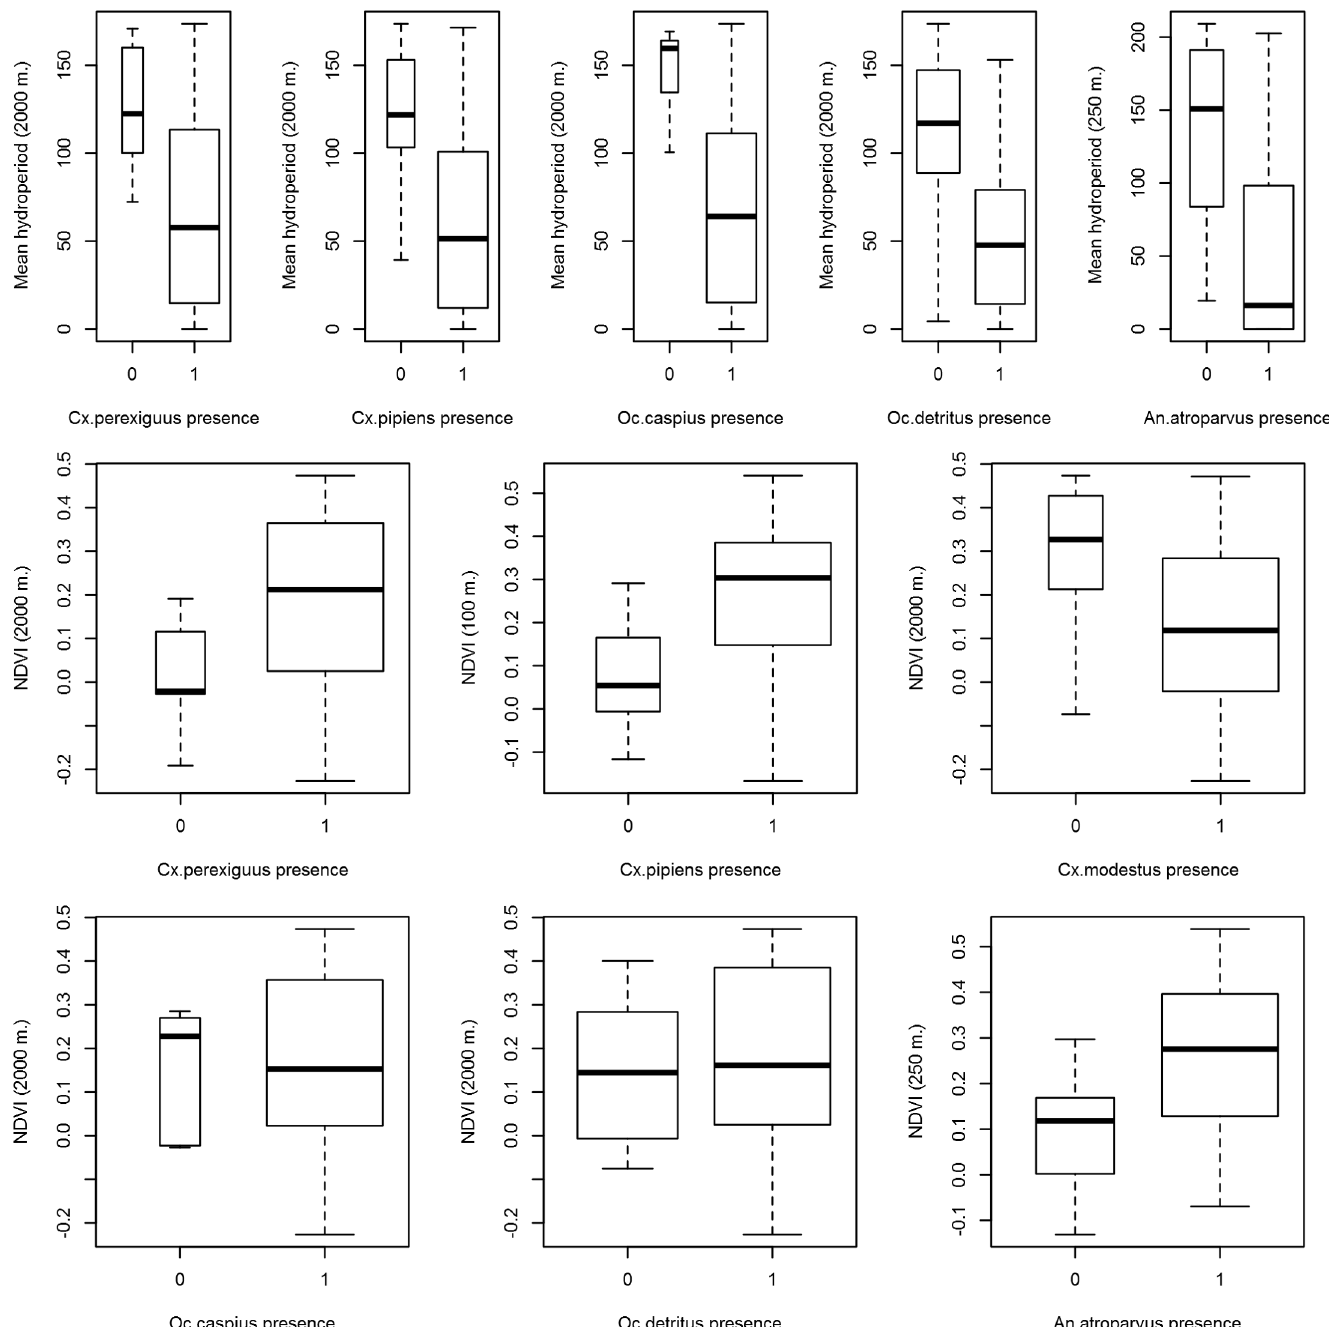
Fig 4. Results of the GLM binomial analysis of the influence of Hydroperiod and NDVI on annual mosquito presences in the five different